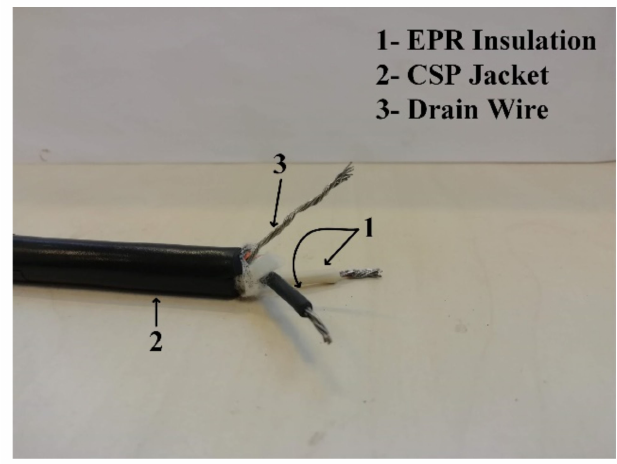
Figure 1. Two-core I&C cable sample under consideration.